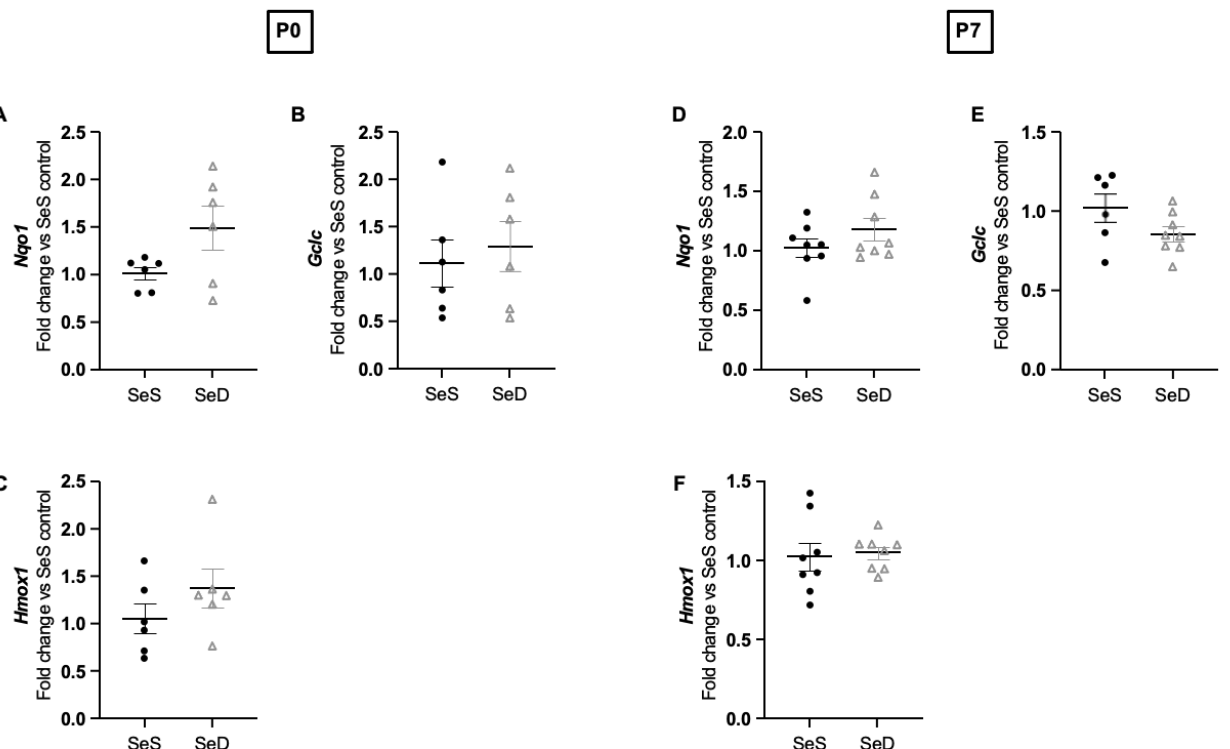
Figure 6. Se deficient neonates have unaltered pulmonary NRF-2 dependent gene transcription at P0 and P7. C57Bl/6 mice were placed on diets that differed only in Se content, either 0.4 ppm or <0.01 ppm of sodium selenite, through pregnancy and lactation. Pulmonary organ homogenate was evaluated on day of birth (P0) and postnatal day 7 (P7). Fold change ( A ) Nqo1 , ( B ) Gclc , ( C ) Hmox1 (normalized to SeS) at P0. Fold change in ( D ) Nqo1 , ( E ) Gclc , ( F ) Hmox1 (normalized to SeS) at P7. N = 4–8 for all groups. Data and presented as mean (±SEM).